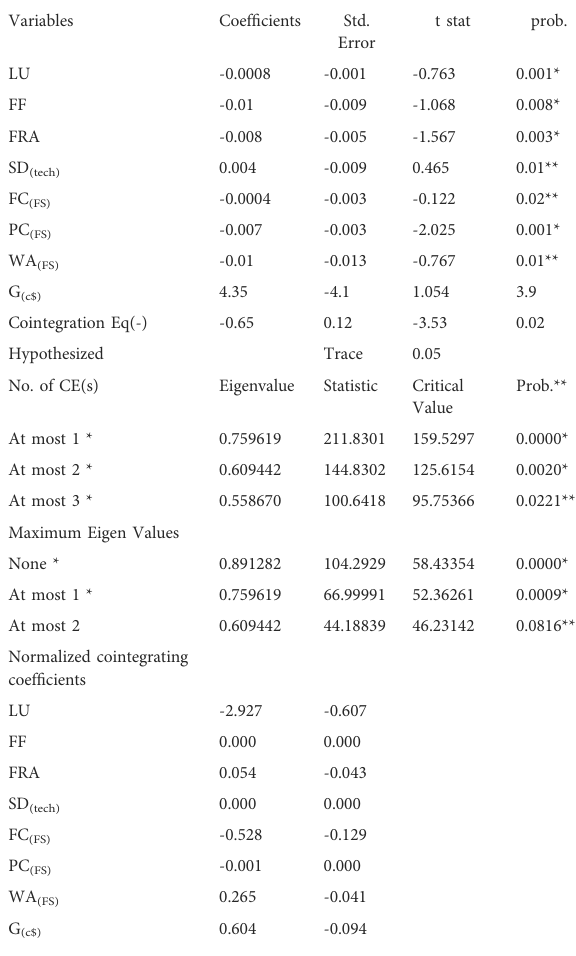
TABLE 5 Estimation of the VECM and Johansen Cointegration. TABLE 3 Structural beak test.